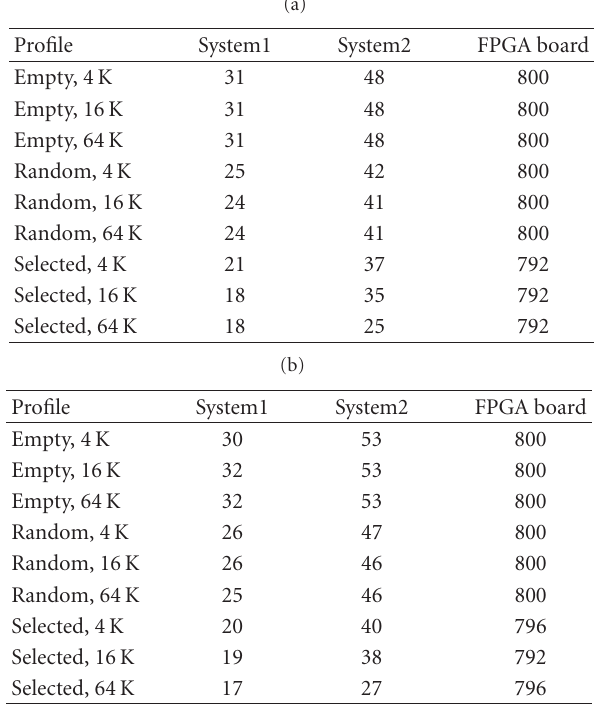
Table 3: Throughput of document filtering application (M terms/s) for (a) 128 K documents of 2048 terms and (b) 512 K documents of 512